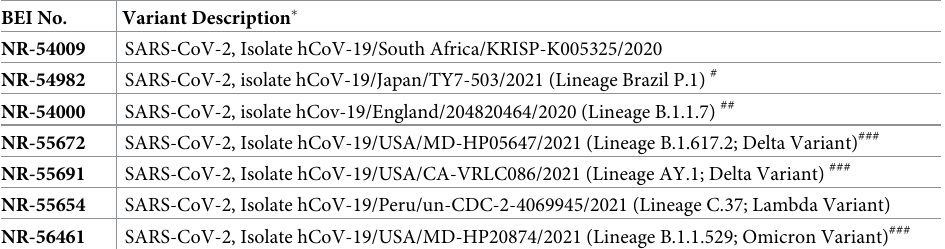
Table 1. SARS-CoV-2 variants. BEI